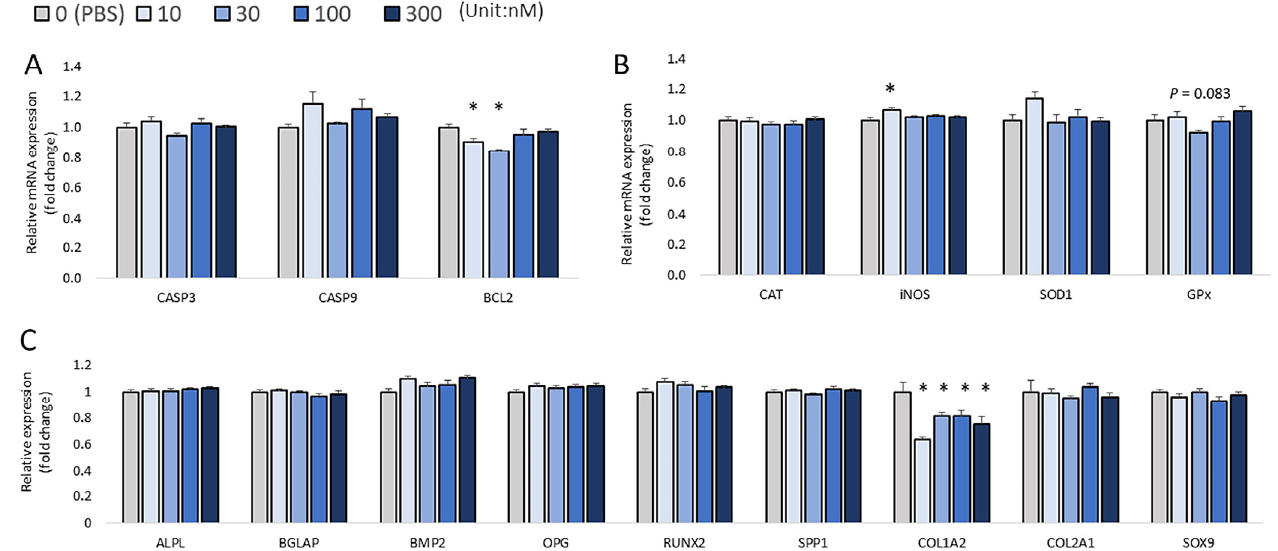
Figure 4. Effects of H 2 O 2 on the mRNA expression of several sets of genes in chicken embryos at 6 h post-injection. ( A ) Apoptotic genes’ expression; ( B ) Antioxidant enzymes’ gene expression; ( C ) Bone formation biomarkers’ expression. Each value represents the mean ± SEM (N = 8). Treatments with * showed a significant difference compared with the control using the Dunnett’s test, p < 0.05. At 24 h post-injection, the expression of BCL2 , an anti-apoptosis regulator, was sig-